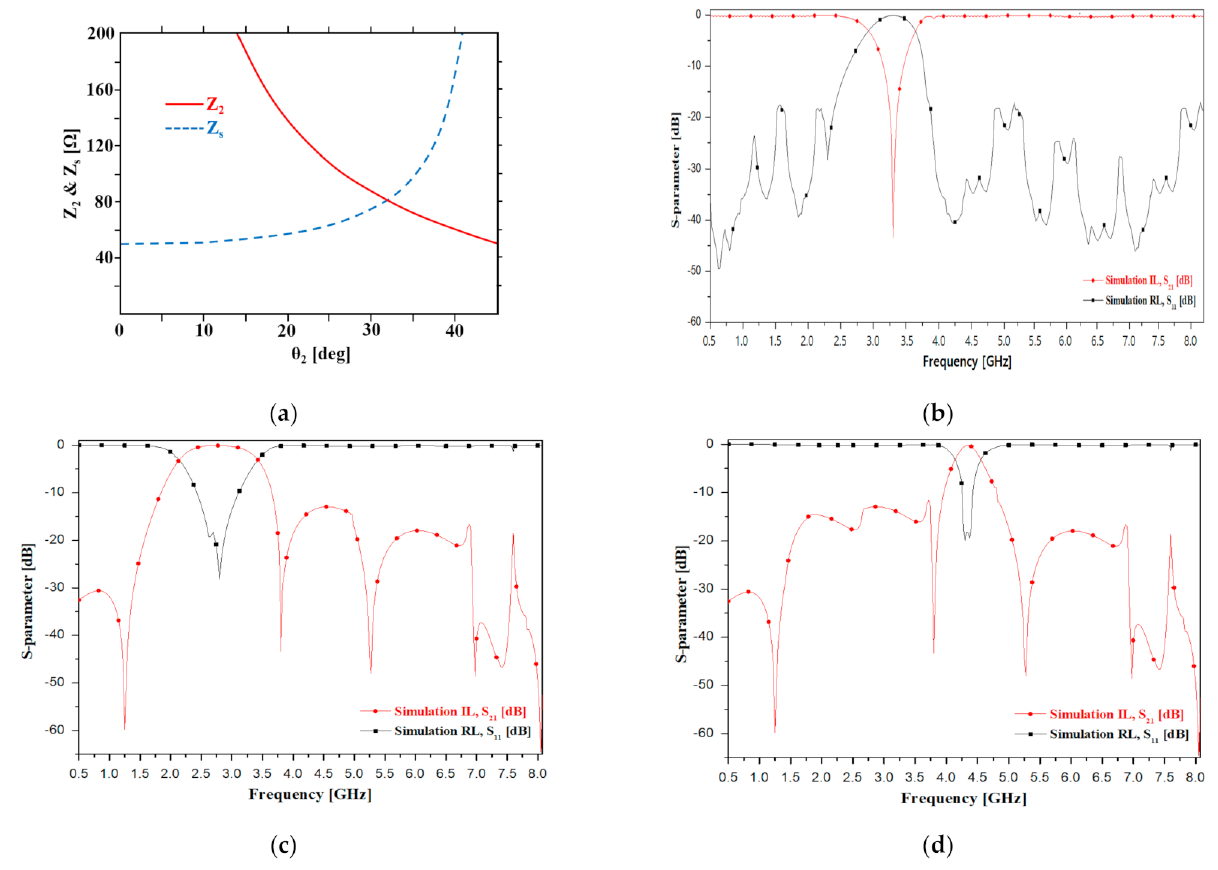
Figure 2. Simulation results for parameter responses. ( a ) Variation of impedance (Z 2 and Z s ) according to θ 2 and ( b ) BSF, ( c ) first frequency band, and ( d ) second frequency band responses. The simulated insertion losses are 0.09 and 0.11 dB, respectively, and the simulated return losses are 24.8 and 23.4 dB at the first and second center frequencies of 3.85 and 5.95 GHz in the BSF,